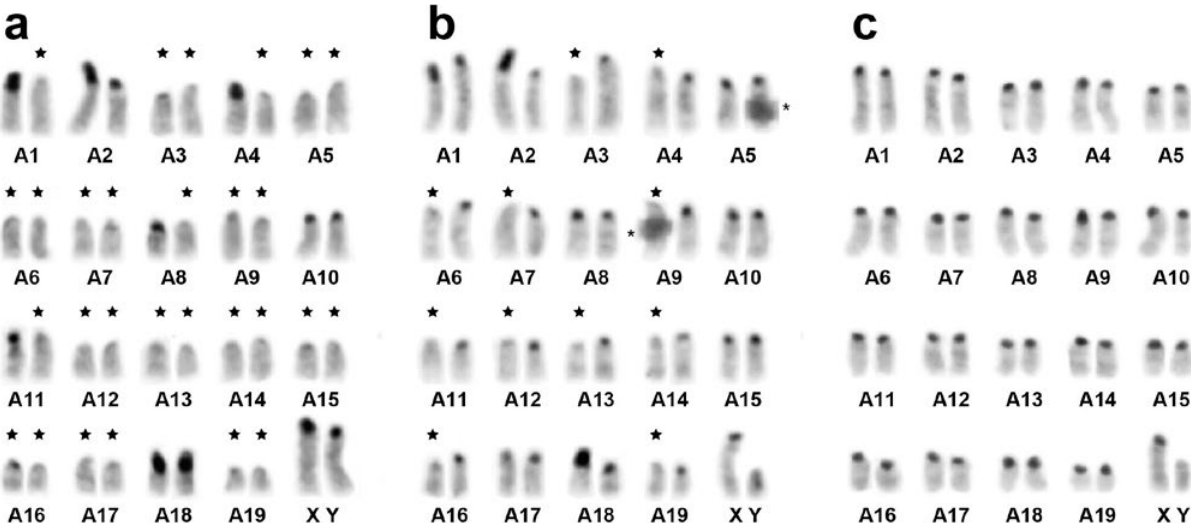
Fig. 2. Typical C-banded karyotypes of a wild-caught mouse (a, MAI-1239), a hybrid mouse (b, MAI-1452), and a C57BL/6N mouse (c, MAI-1301). Stars indicate chromosomes with null C-bands. Asterisks indicate crossing of